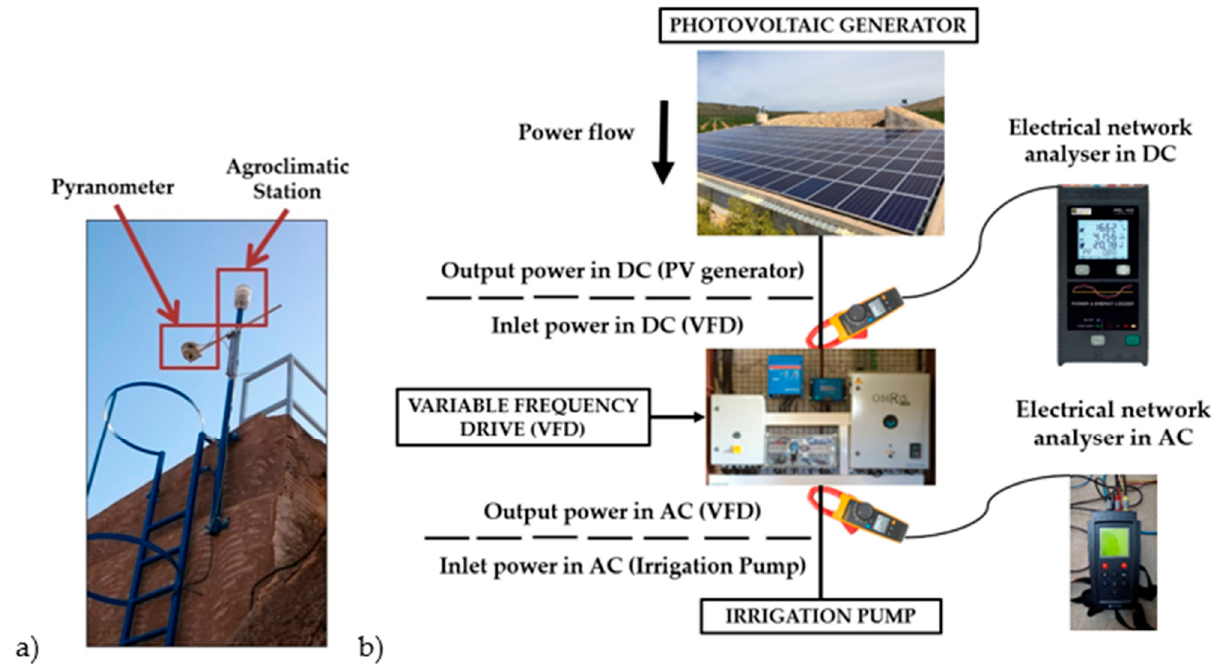
Figure 1. ( a ) Location of the pyranometer and agro-climatic station and ( b ) Location of the electrical network analysers in the inlet and output of the variable frequency drive (VFD).